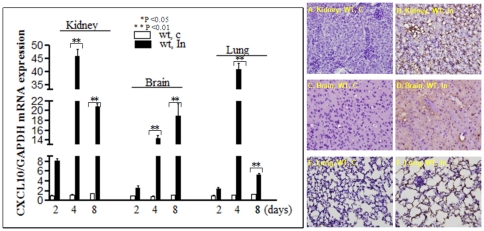
ECM is associated with high levels of CXCL10 expression in vital organs in C57BL/6 WT mice.Left panel: CXCL10 messenger RNA (mRNA) expression in kidney, brain, and lung as determined by quantitative RT-PCR. Data are shown as mean ± SD (n = 6 per group). *P<0.05; ** P<0.01. ECM onset in C57BL/6 mice infected with P. berghei ANKA reveals that levels of CXCL10 mRNA were much higher in kidney, brain and lung tissues in infected than uninfected mice on day 4 and day 8 respectively (left panel). Right panel (Figure 6A–6F): representative examples of HO-1 immunohistochemistry staining in kidney, brain and lung of C57BL/6 wild type mice. Membrane and cytoplasma staining of CXCL10 protein were much stronger in the kidney, brain and lung of PBA infected WT C57 BL/6 mice compared to corresponding controls (Figure 6B vs. 6A, 6D vs. 6C, 6F vs.6E).